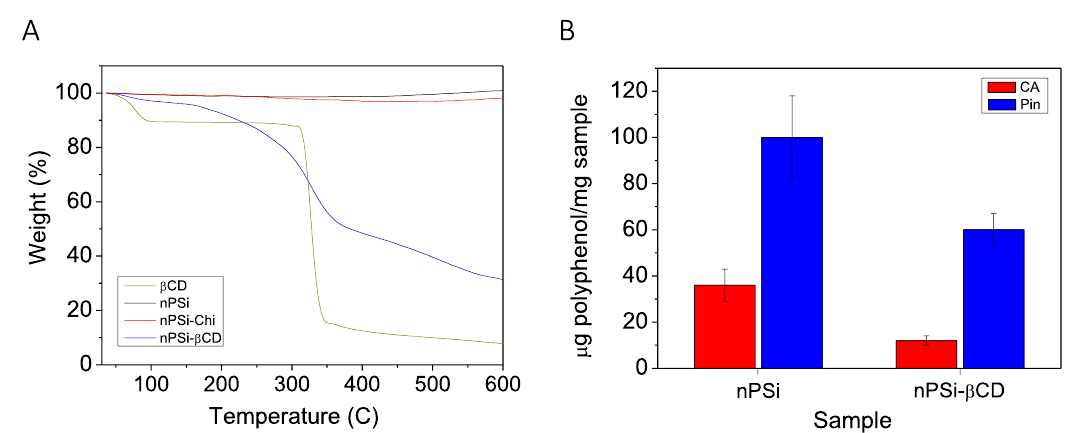
Figure 6. ( A ) Thermogravimetric analysis (TGA) of microparticles at different stages of synthesis, and ( B ) Polyphenols capacity loading of nPSi-βCD composite microparticles.